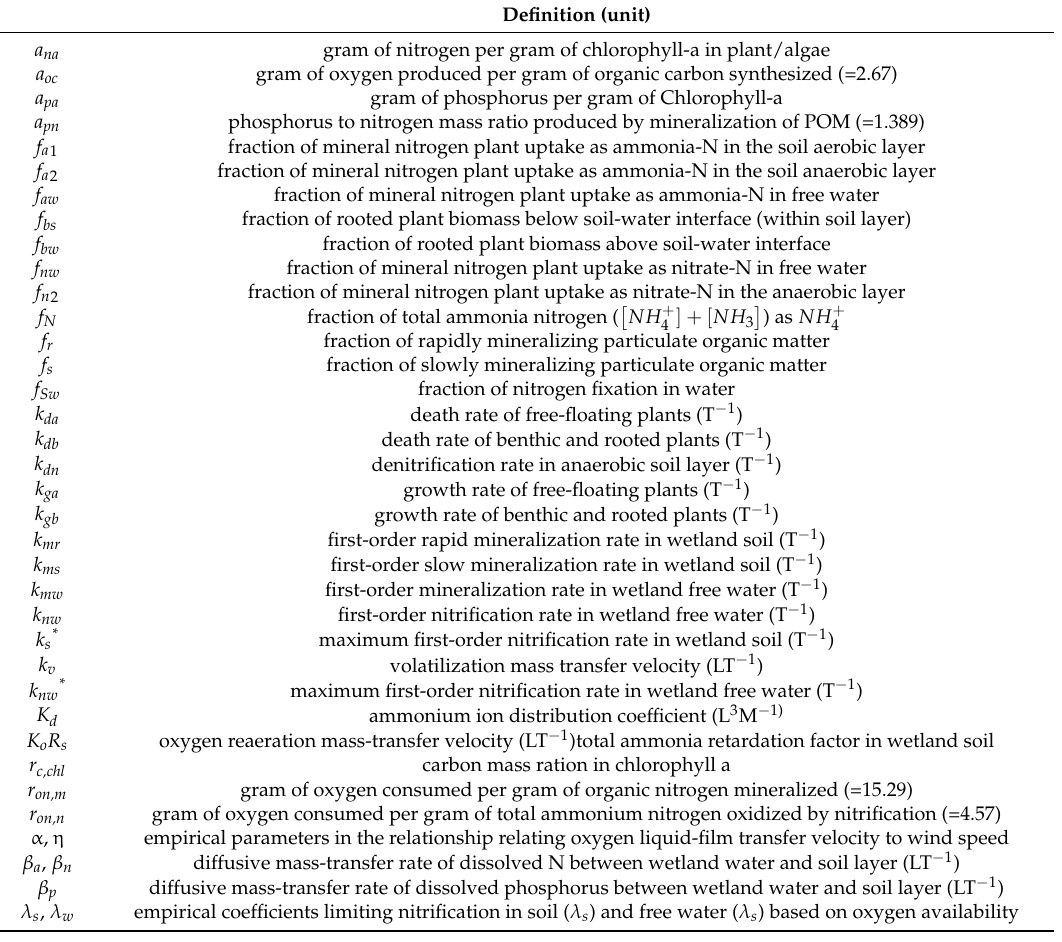
Table 1. Wetland model parameter